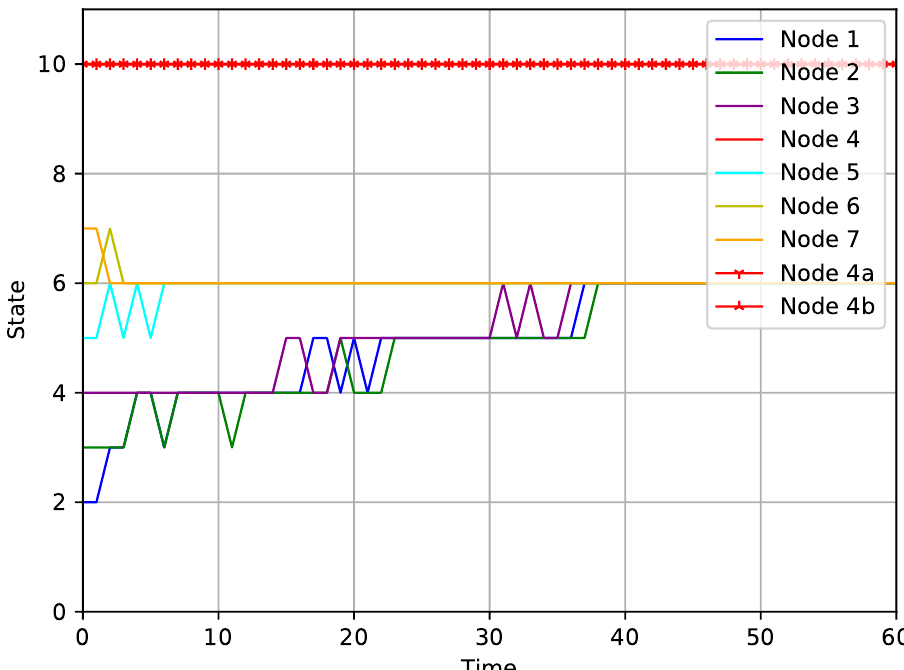
Figure 8. Simulation results of our proposed algorithm under ( 2,2 ) -robust network.